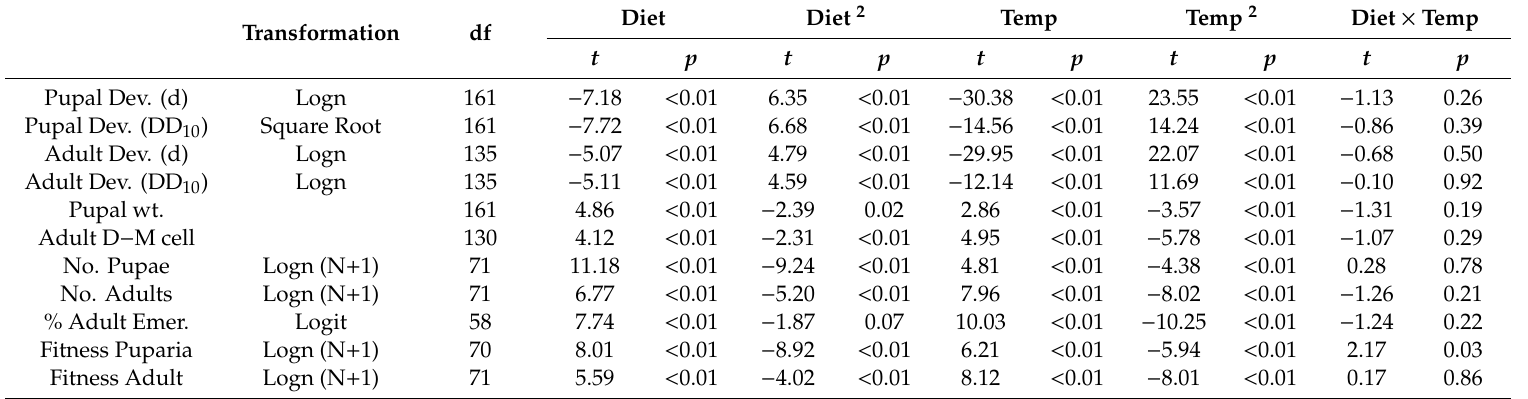
Table 2. Statistics for GLMM models with diet and temperature considered continuous variables.